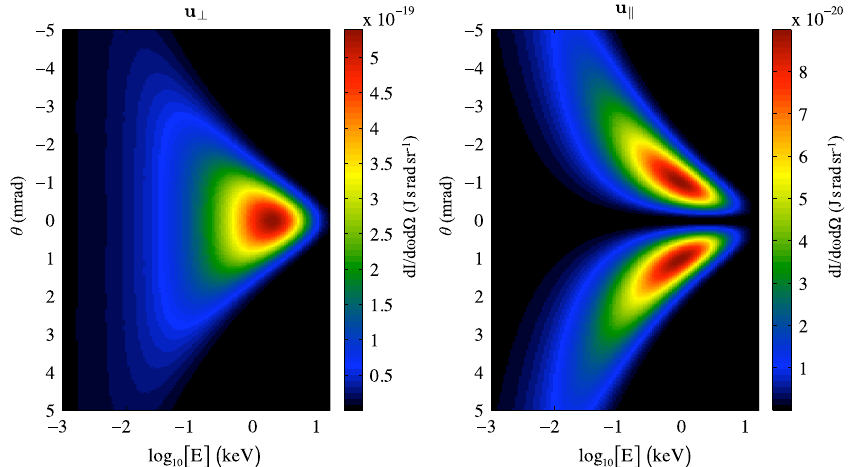
FIG. 3. (Color) Calculated angularly resolved polarization components of synchrotron spectra for an electron Lorentz factor of (cid:10) ¼ 13 T . The time step is ! (cid:2) (cid:4) ¼ (cid:3) (cid:2) 10 (cid:1) 4 . (left) u 1000 , and a magnetic field strength of B 0 ¼ 0 ? is the radiated spectral power polarized in the plane of the motion of the electron. (right) u jj is the radiated spectral power polarized parallel to the magnetic